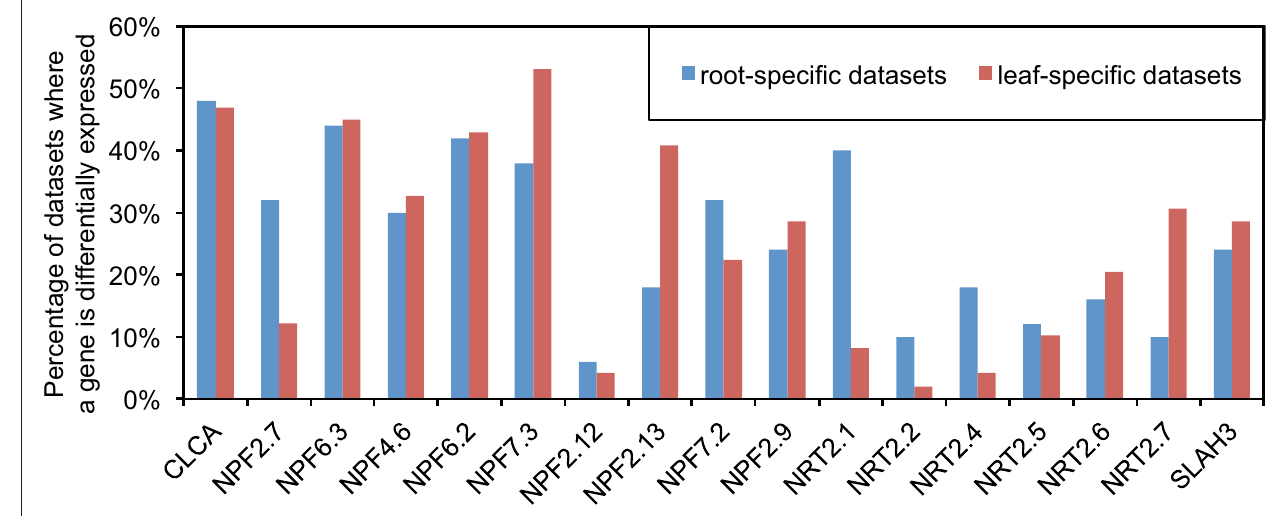
FIGURE 1 | Comparison of differential expression between roots and leaves for N transporters. ANOVA followed by FDR was utilized to detect differential expression between replicated groups in each GEO datasets ( p < 0.01). There are 50 datasets which contain root samples only and 49 datasets which contain leaf samples only among 371 datasets collected for this study (see Table S2 for